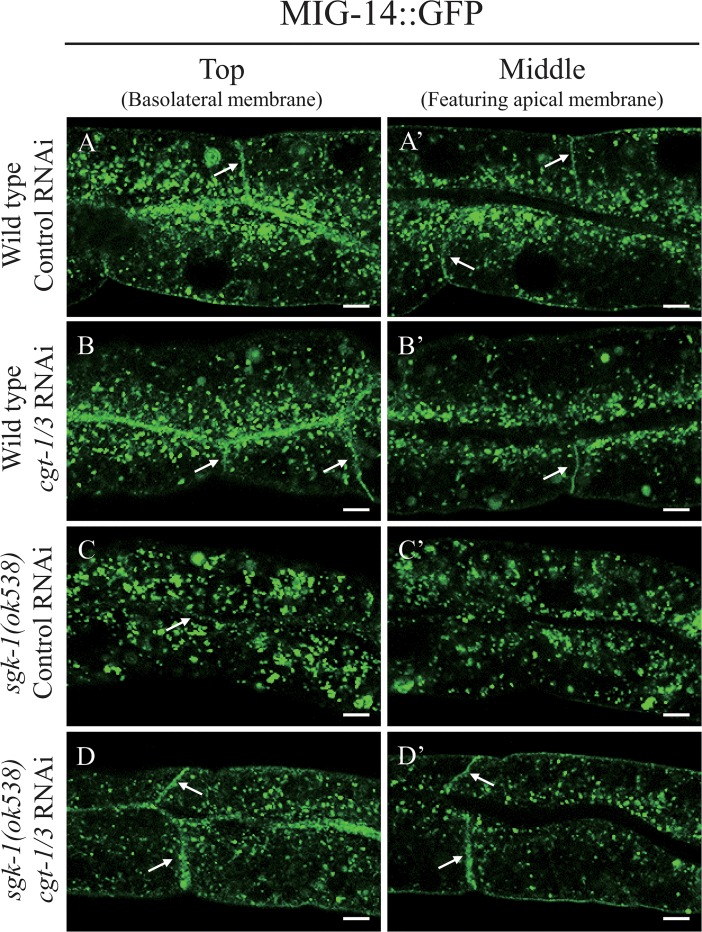
The effect of cgt-1/3 double RNAi on the localization patterns of MIG-14::GFP.Confocal images of intestinal cells of wild type worms treated with control RNAi (A, A’), cgt-1/3 double RNAi (B, B’) and sgk-1(ok538) mutant animals treated with control RNAi (C, C’), cgt-1/3 double RNAi (D, D’) expressing MIG-14::GFP. The basolateral membranes were indicated by arrows. Scale bars: 5 μm.